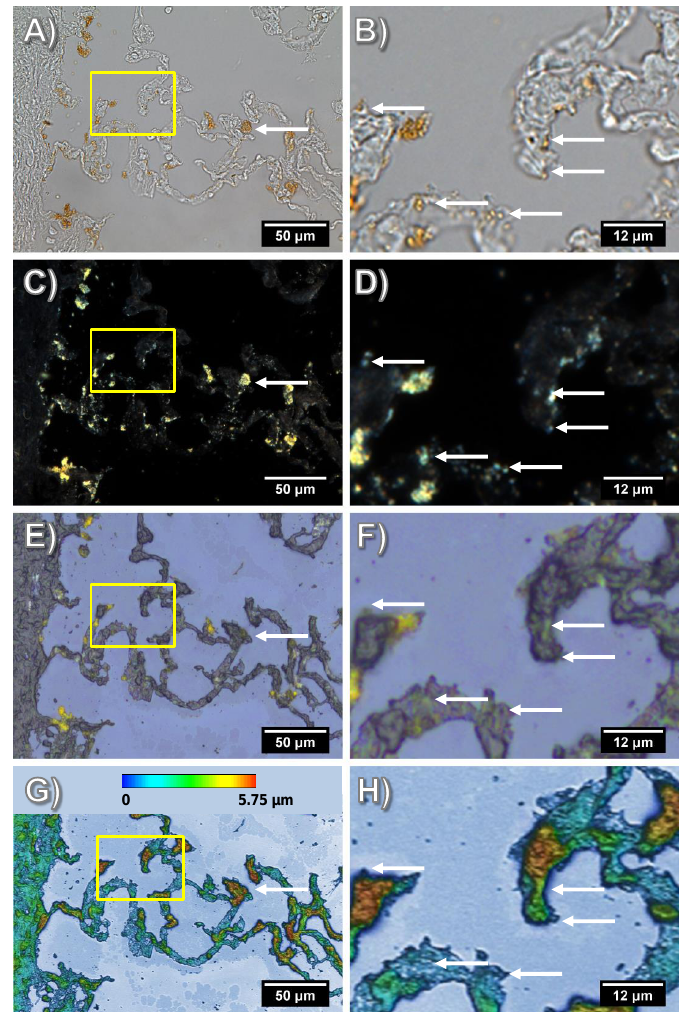
Figure 3. Light microscopic analyses of a Fe-Si-NP-laden cryo-section from rat lung. Overview ( A , C , E , G ) and detail ( B , D , F , H ) of the boxed area shown on the left. ( A – D ) Routine images of the coverslipped section taken with bright-field optics ( A , B ) and DFM ( C , D ); Fe-Si-NP agglomerates appear as brownish patches at alveolar septa or in macrophages. With DFM, additional small light-scattering particles are seen alongside alveolar septa. ( E – H ) Same tissue area after removal of the coverslip, rinsing and drying. ( E , F ) Microscopic image of the dry section without coverslip, taken with a reflective light microscope. Prominent Fe-Si-NP agglomerates are still identifiable as yellow patches. ( G , H ) Optical profilometry analysis showing the relief structure of the dry lung section as subjected to ToF-SIMS; the topographic map reveals an amplitude of several micrometers. Arrows in ( A , C , E , G ) point to a particle-laden macrophage ( A , C ), which became lost in the course of tissue preparation. Similarly, arrows in ( B , D , F , H ) point to small Fe-Si-NP (seen in ( B , D )), which were absent after drying. Bright-field microscopy and DFM demand that the tissue section is immersed in ringer solution, coverslipped and viewed with oil-immersion lenses. As ToF-SIMS analysis is carried out under